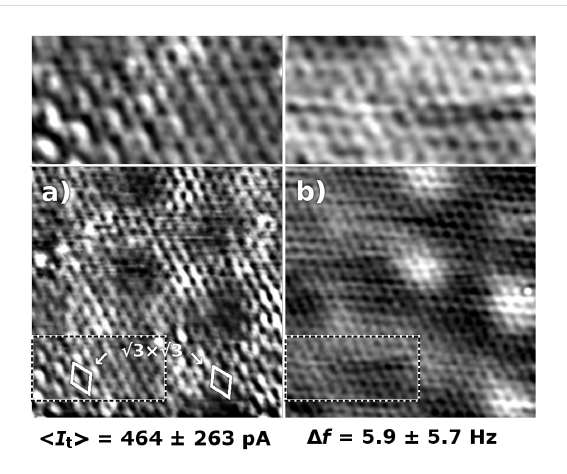
Figure 3: (a) The average tunneling current < I t > maps ( V bias = 100 mV, I = 0.46 nA, 5.5 nm × 7.1 nm and (b) frequency shift Δ f acquired on the same area of graphene/SiC(0001). The q-6 modulation is apparent in both channels, whereas the × modu- lation due to scattering on armchair boundary is detected only in the < I t > map. The insets on the top show zoomed images of a region that has a × modulation in the < I t > map. The mean value and a standard deviation (RMS) are given for each measured quantity beneath each of the